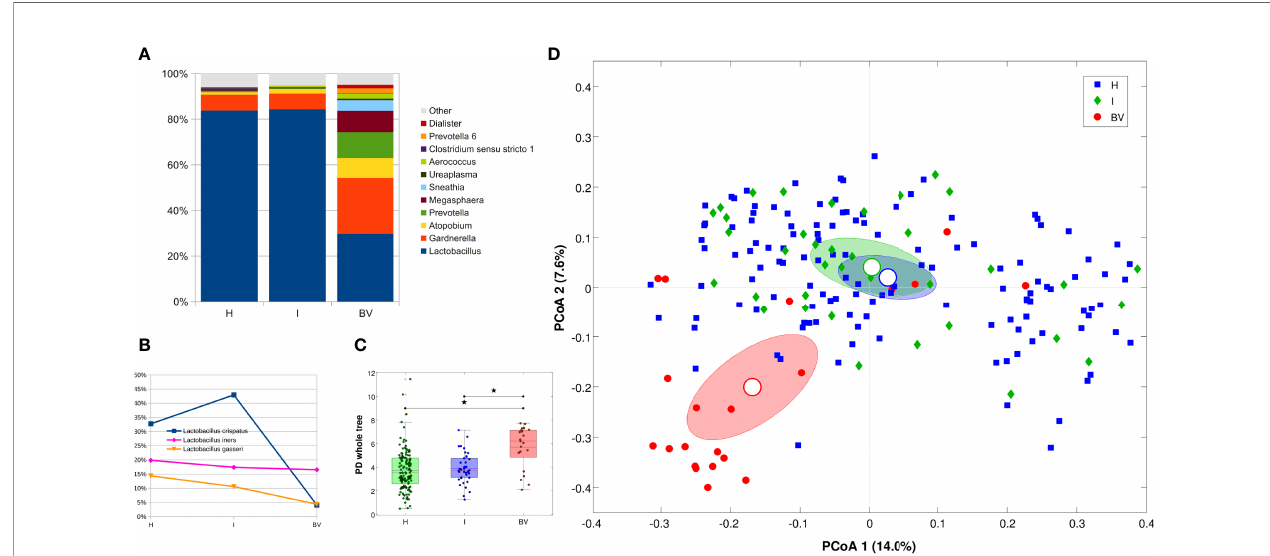
FIGURE 1 | Microbiota characterization according to the vaginal status (H, I or BV). (A) Barplot of average relative abundances at genus level. Genera with rel. ab. ≤ 1% were grouped in “ Others ” category; (B) Line plot of average Lactobacillus species abundance per vaginal status; only the 3 most abundant species are represented; (C) Boxplot of Faith ’ s phylogenetic diversity of the samples (estimated at endpoint) for each vaginal status. Stars above the plots represent statistical signi fi cance (p<0.05); (D) Principal Coordinate Analysis (PCoA) based on unweighted Unifrac distance among samples. Each point represents a sample; ellipses are 95% SEM-based con fi dence intervals; point and ellipses are grouped according to vaginal status; the fi rst and the second coordinate are